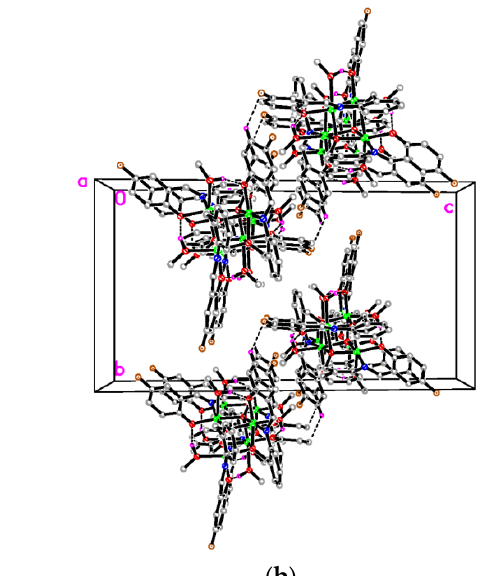
7 of 13 Figure 2. Crystal structures of ( a ) complex 1 (unlabeled atoms are related to the symmetry operation 1 – x, y, 3/2 – z.) and of ( b ) complex 2 . Hydrogen atoms except for those related to hydrogen bonds have been omitted for clarity. Intramolecular O–H···O hydrogen bonds are shown as dashed lines. ( a ) ( b ) Figure 3. Cubane core ( a ) and fragment of structure 1 ( b ), emphasizing the binding mode of ligand (L 1 ) 2 − for Ni II . In contrast to compound 1 , there is no crystallographic two-fold rotation axis imposed on cluster